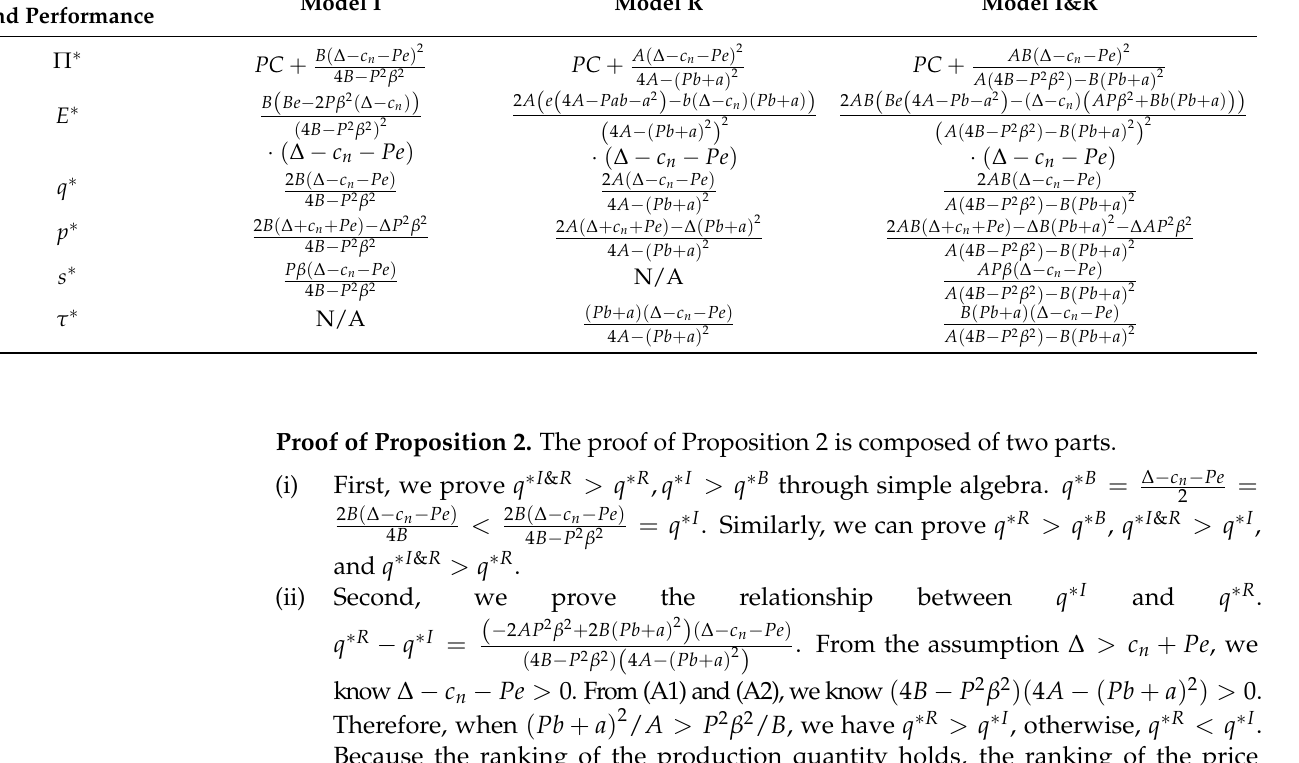
Table A2. Comparison of the manufacturer’s carbon abatement models with cap-and-trade. Optimal Decisions Model I Model R Model and Performance